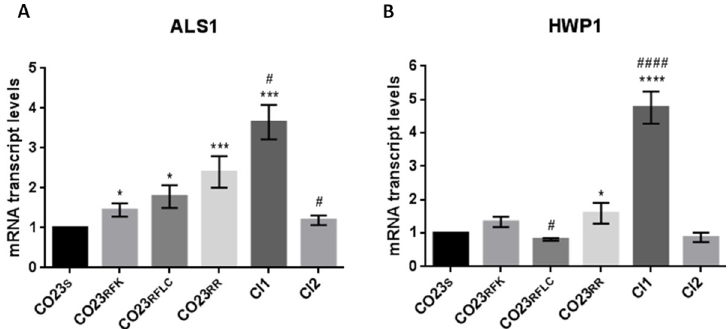
Fig 4. Expression levels of C . albicans ALS1 and HWP1 genes determined by real-time PCR. The expression level of the ALS1 (A) and HWP1 (B) genes in the wild-type (CO23), resistant (CO23RFK, CO23RFLC and CO23RR) strains and Clinical Isolates (CI1 and CI2) are represented as n-fold increase or decrease relative to the level of the control strain (CO23). Data are shown as mean ± SEM from three independent experiments performed in triplicate. � p < 0.05, # p < 0.05, ## p < 0,01, ### p < 0.001, #### p < 0,0001 vs CO23 �� p < 0.01, ��� p < 0.001, ���� p < 0.0001 vs CO23 S and RR .